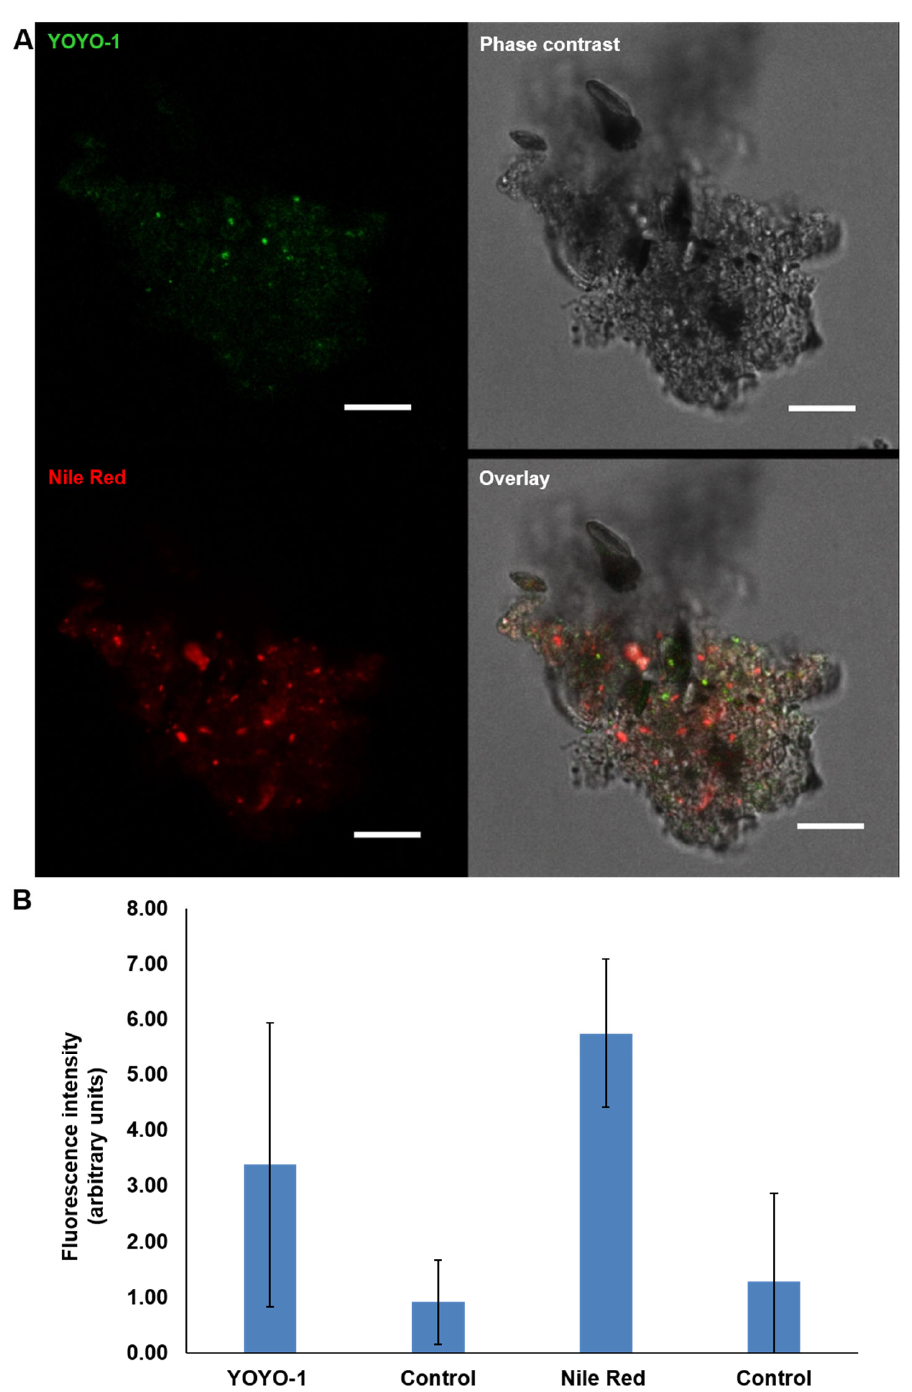
Figure 4. CLSM images acquired using Leica SP8 of natural MGPs stained with YOYO-1 to localise the presence of eDNA (green). Nile red (red) was used as a counter stain for bacterial cell membranes. Scale bar = 5 µ m ( A ). Image captured using 63 × objective. Quantification of the fluorescence intensity of each fluorophore against the control (unstained MGPs) ( B ). The graph presents the mean ± SD of 15 CLSM micrographs. Error bars represent the standard deviation of the data set ( n = 3), p <